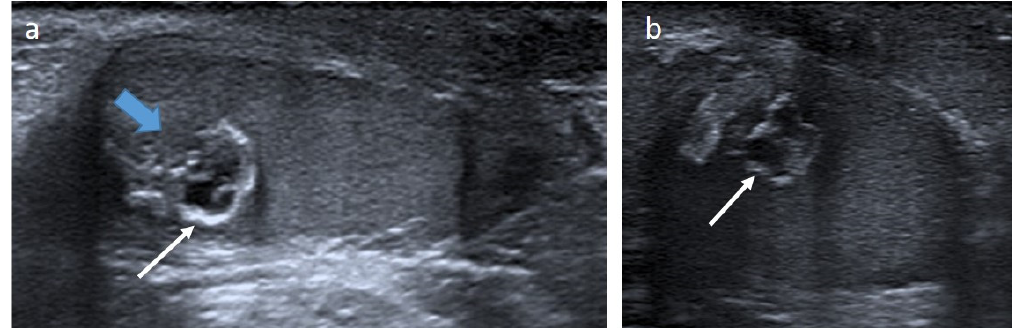
Figure 2. Epidermoid cyst in a 20-month-old boy. Longitudinal ( a ) and transverse ( b ) gray-scale B mode US of the testis. Images show a well-demarcated intra-testicular lesion (blue arrow) with a small central anechoic part and a peripheral hyperechoic rim, giving an “onion-ring appearance” (white arrows). This lesion was incidentally discovered on scrotal US for a contralateral undescended testis. Serum levels of tumor markers were normal. The patient underwent conservative surgery. US, ultrasonography.